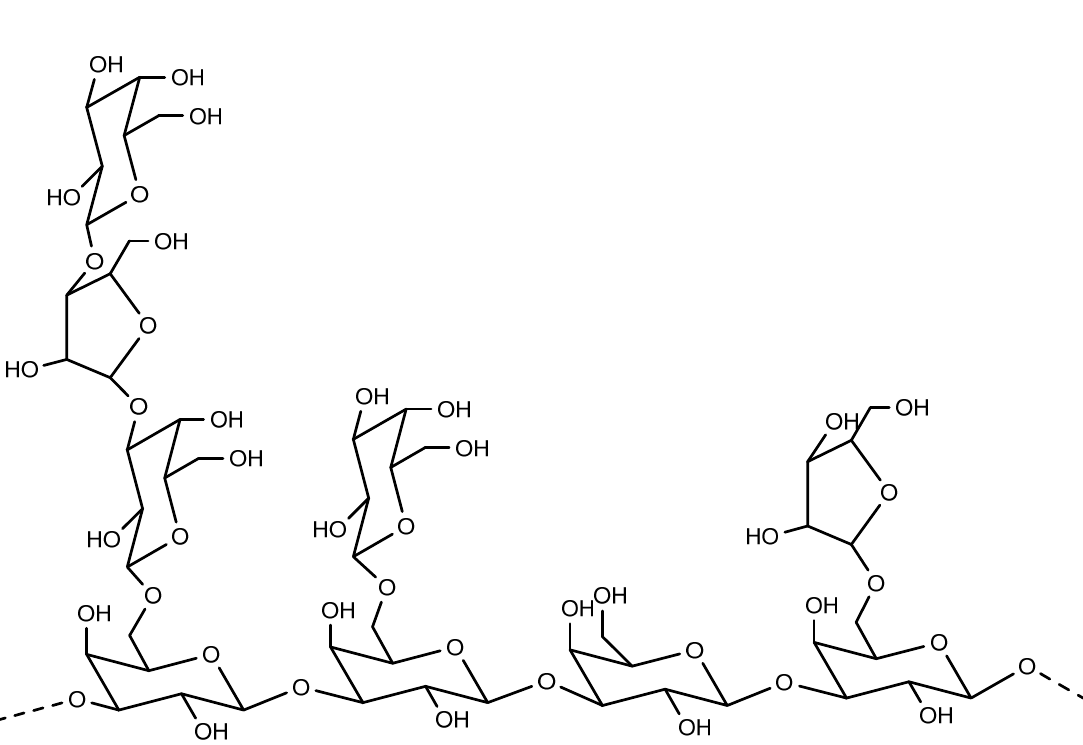
Figure 5. Fragment of Arabinogalactan (AG).